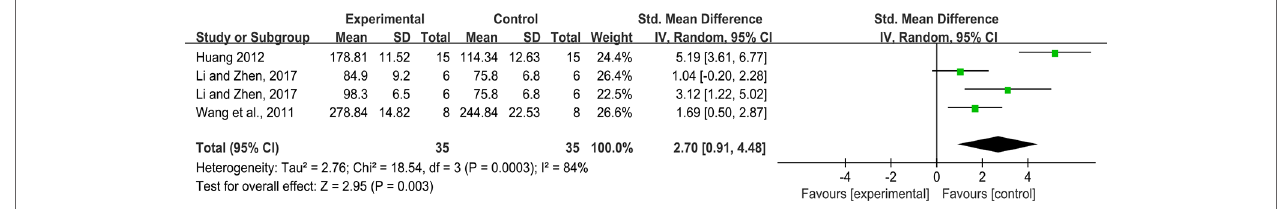
FiGURe 8 | Pooled estimate of SOD with rhein.